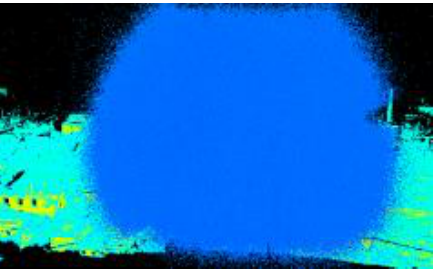
Fig.4 Noisy data under rainy weather condition